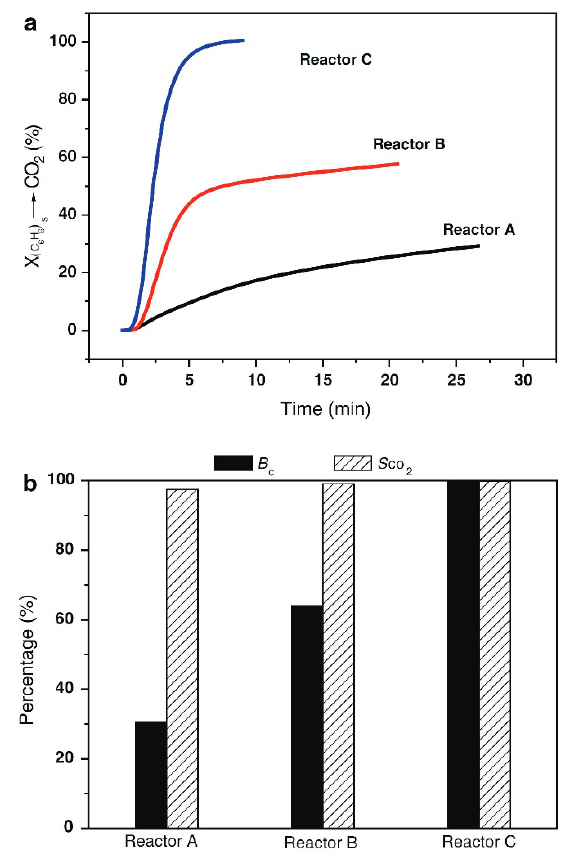
Figure 3. The effect of plasma catalytic reactor configurations on removal of stored benzene over 0.8 wt.% Ag/HZSM-5 catalysts ( a ) the conversion of stored-benzene to CO 2 , ( b ) carbon balance and CO 2 selectivity (storage stage with 4.7 ppm benzene, 50% RH (25 °C), 600 mL/min flow rate of simulated air, t 1 = 1 h; discharge stage: 60 mL/min O 2 , P = 4.7 W). Reprinted from Ref. [42], with permission from